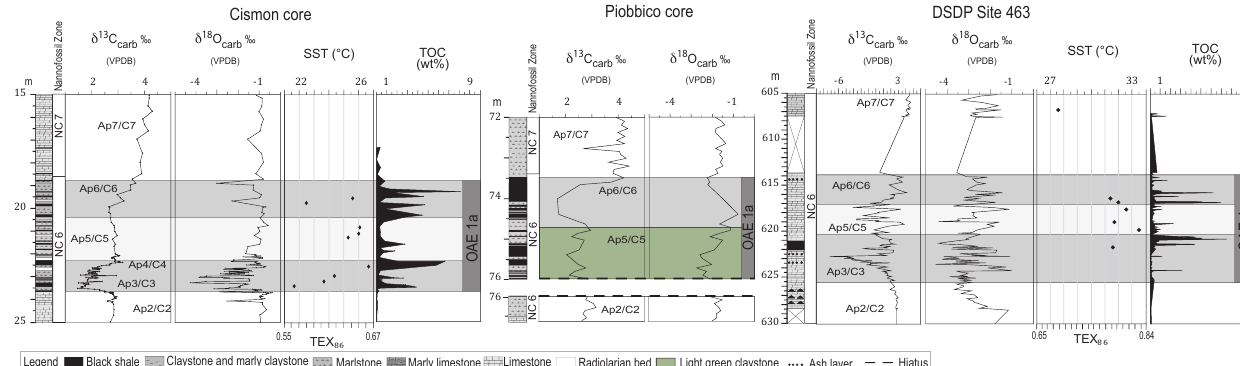
Figure 2. Correlation between the Cismon core, the Piobbico core and DSDP Site 463. δ 13 C data after Erba et al. (1999) and Méhay et al. (2009) for the Cismon core; Erba et al. (2015) for the Piobbico core; Price (2003), Ando et al. (2008) and Bottini et al. (2012) for DSDP Site 463. Bulk δ 18 O data after Erba et al. (2010) for the Cismon core; Price (2003), Ando et al. (2008) and this work for DSDP Site 463. TOC after Erba et al. (1999) and Bottini et al. (2012) for the Cismon core; Ando et al. (2008) for DSDP Site 463. TEX 86 after Schouten et al. (2003) for DSDP Site 463; this work for the Cismon core. For both cores SST was calculated using the equation of Kim et al. (2010). Grey bands indicate intervals of higher TOC